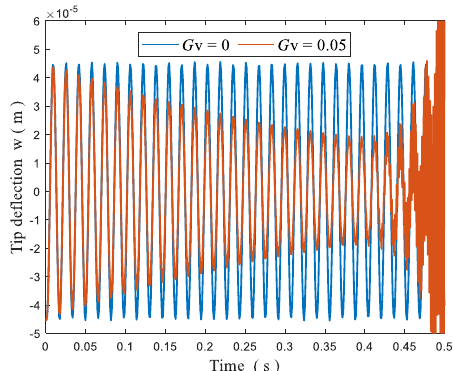
Figure 15. Tip deflection of a cantilevered plate with n = 1 by using a geometric middle surface.